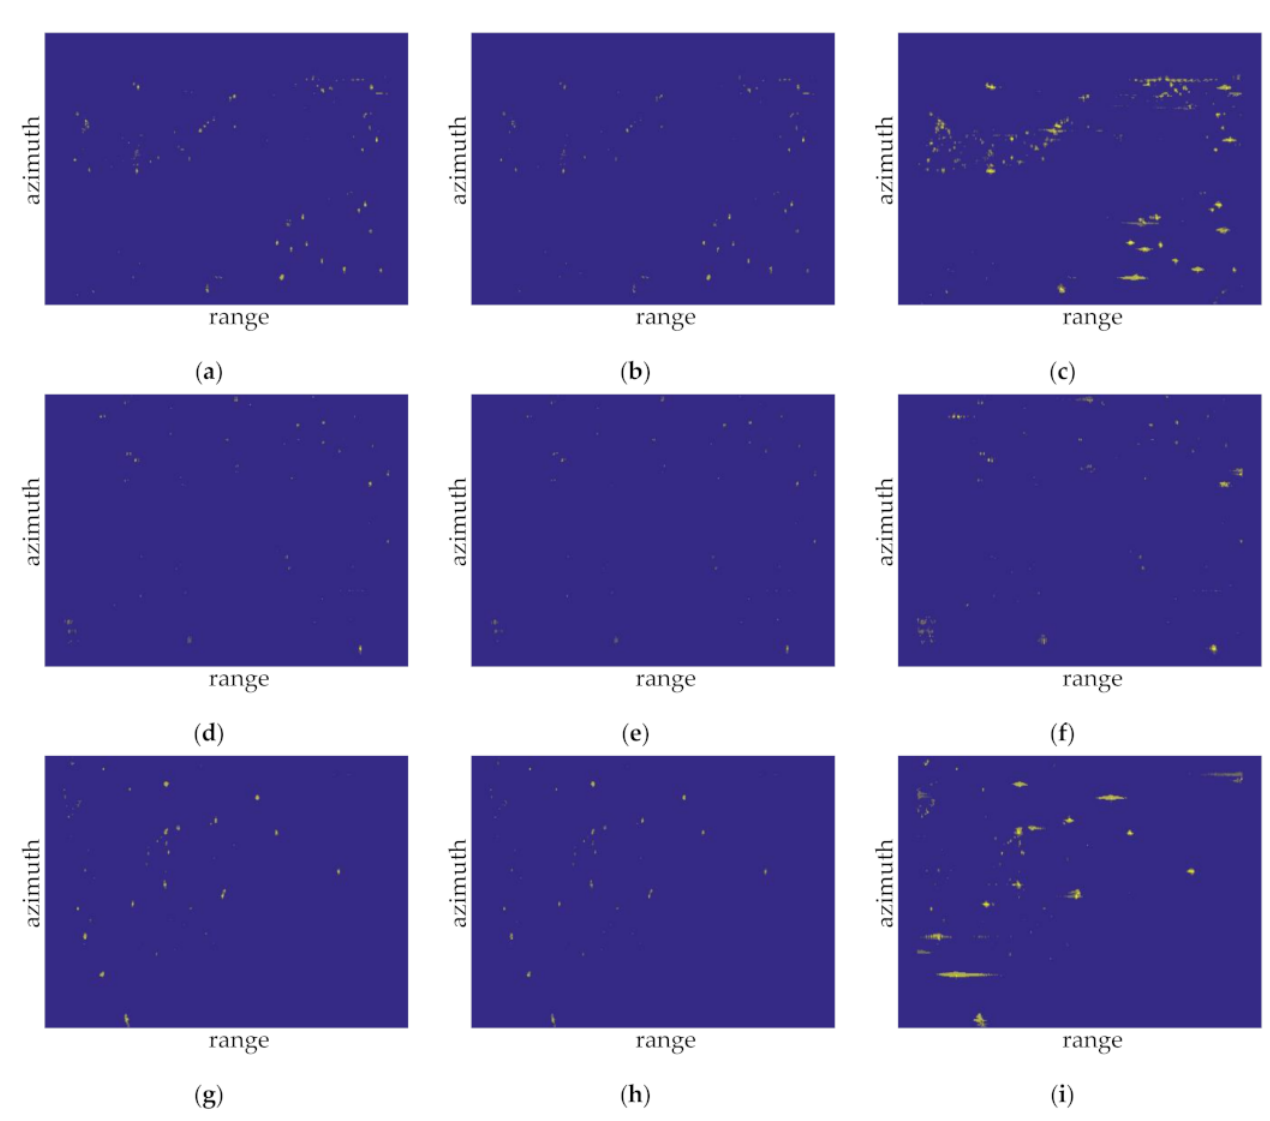
Figure 16. Detection results of the samples for the CA-CFAR, GOCA-CFAR, and SOCA-CFAR algorithms in offshore water: ( a ) the CA-CFAR detection results of sample 1; ( b ) the GOCA-CFAR detection results of sample 1; ( c ) the SOCA-CFAR detection results of sample 1; ( d ) the CA-CFAR detection results of sample 2; ( e ) the GOCA-CFAR detection results of sample 2; ( f ) the SOCA-CFAR detection results of sample 2; ( g ) the CA-CFAR detection results of sample 3; ( h ) the GOCA-CFAR detection results of sample 3; and ( i ) the SOCA-CFAR detection results of sample